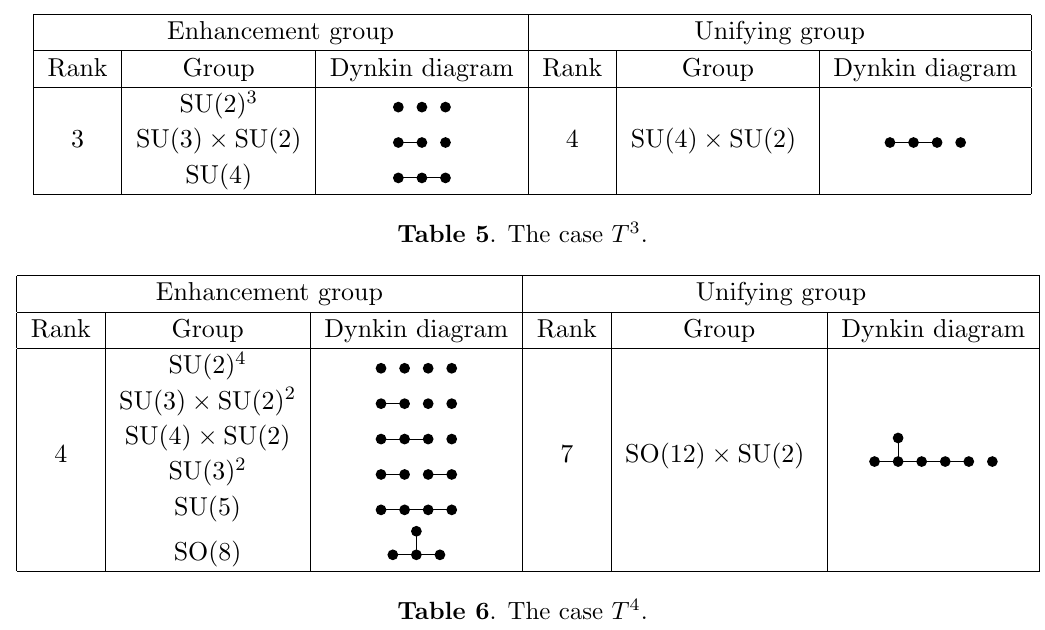
Table 4 . The case T 2 . The groups refer to one single sector, say the left-moving one.